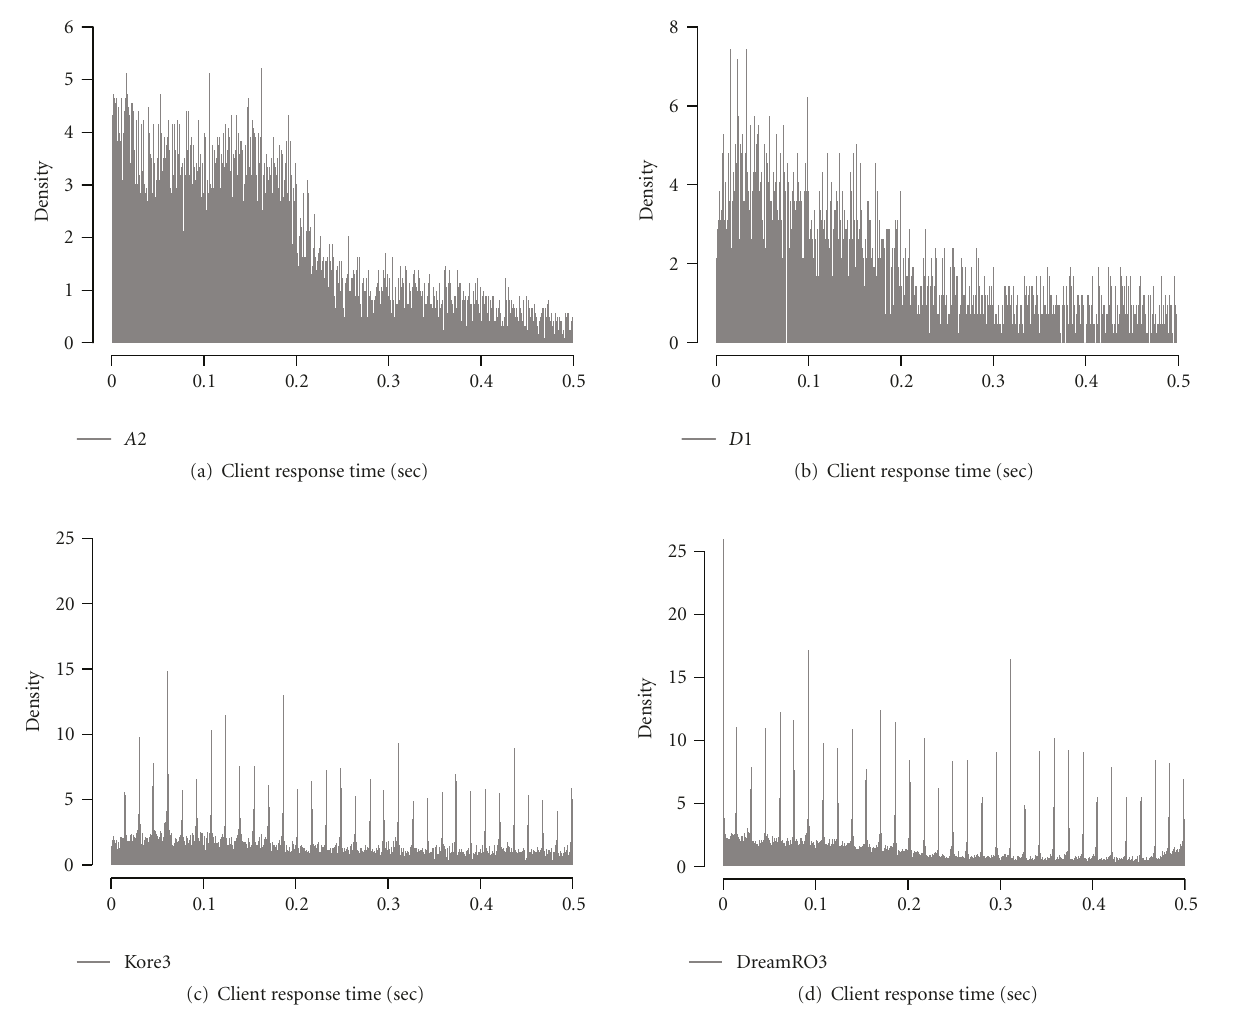
Figure 8: Histogram of client response times shorter than 0.5